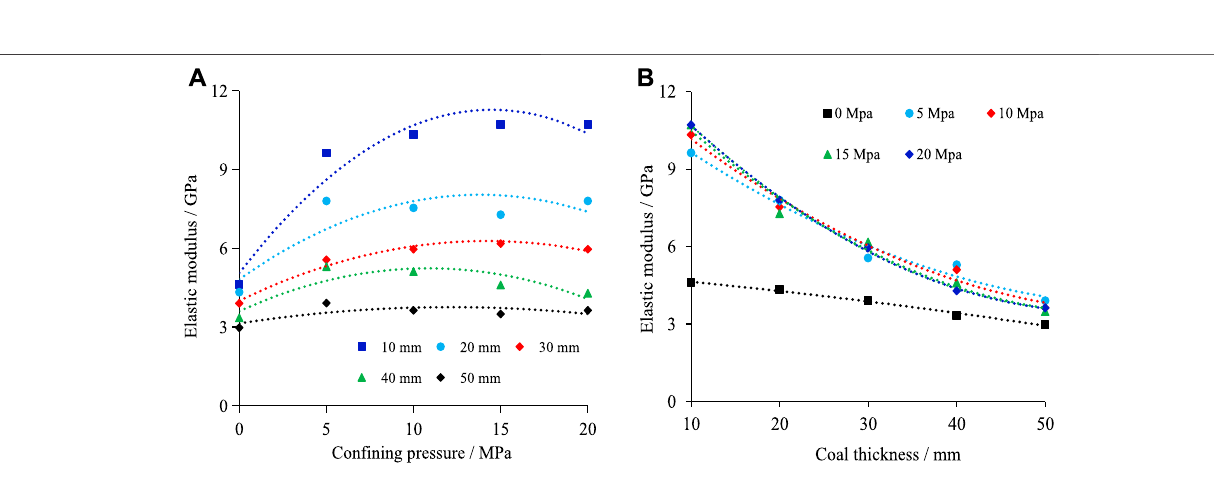
Frontiers in Physics |